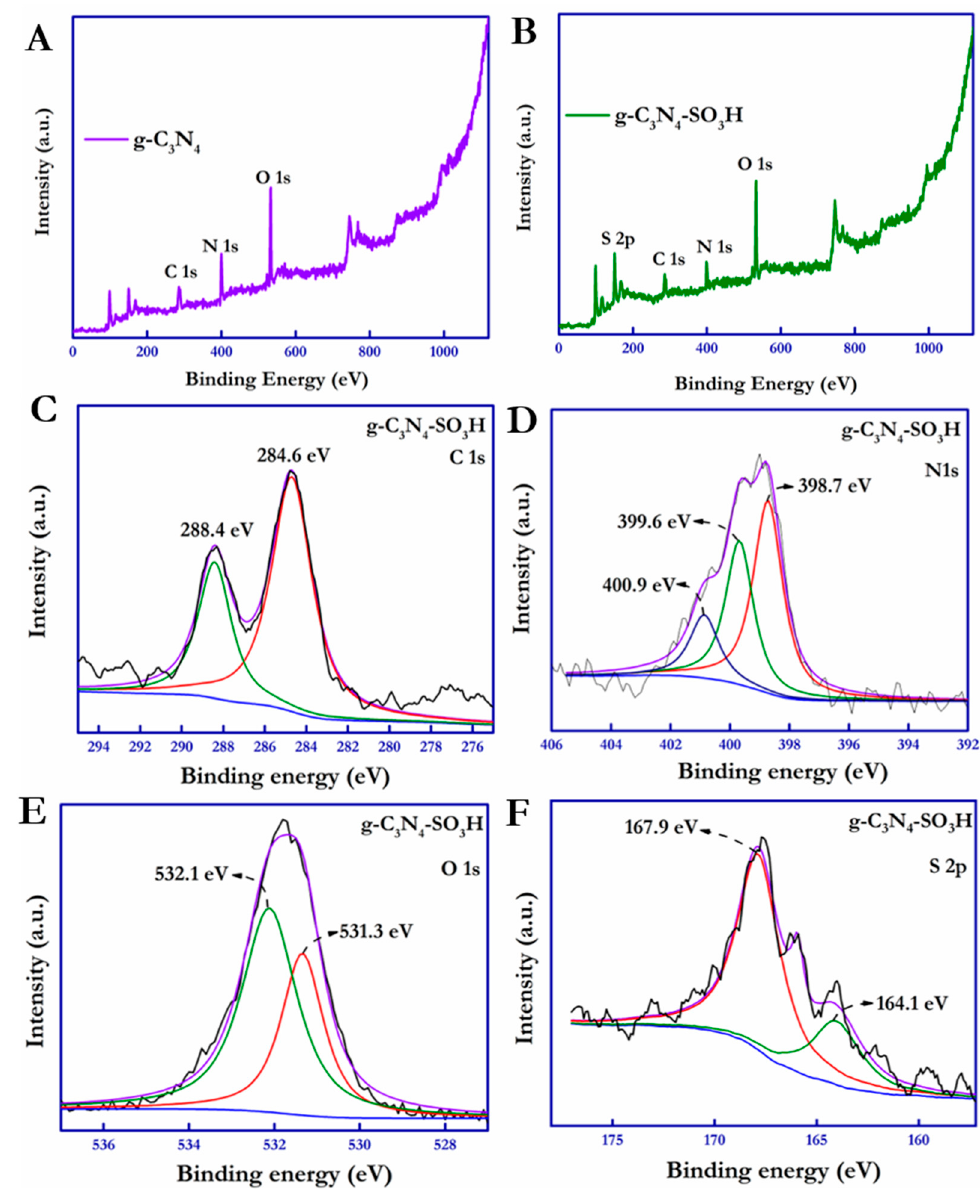
Figure 6. Complete XPS survey spectra of prepared g-C 3 N 4 and g-C 3 N 4 –SO 3 H ( A , B ) and individual deconvoluted C 1s , N 1s , O 1s , and S 2p ( C – F ) spectra of g-C 3 N 4 –SO 3 H.